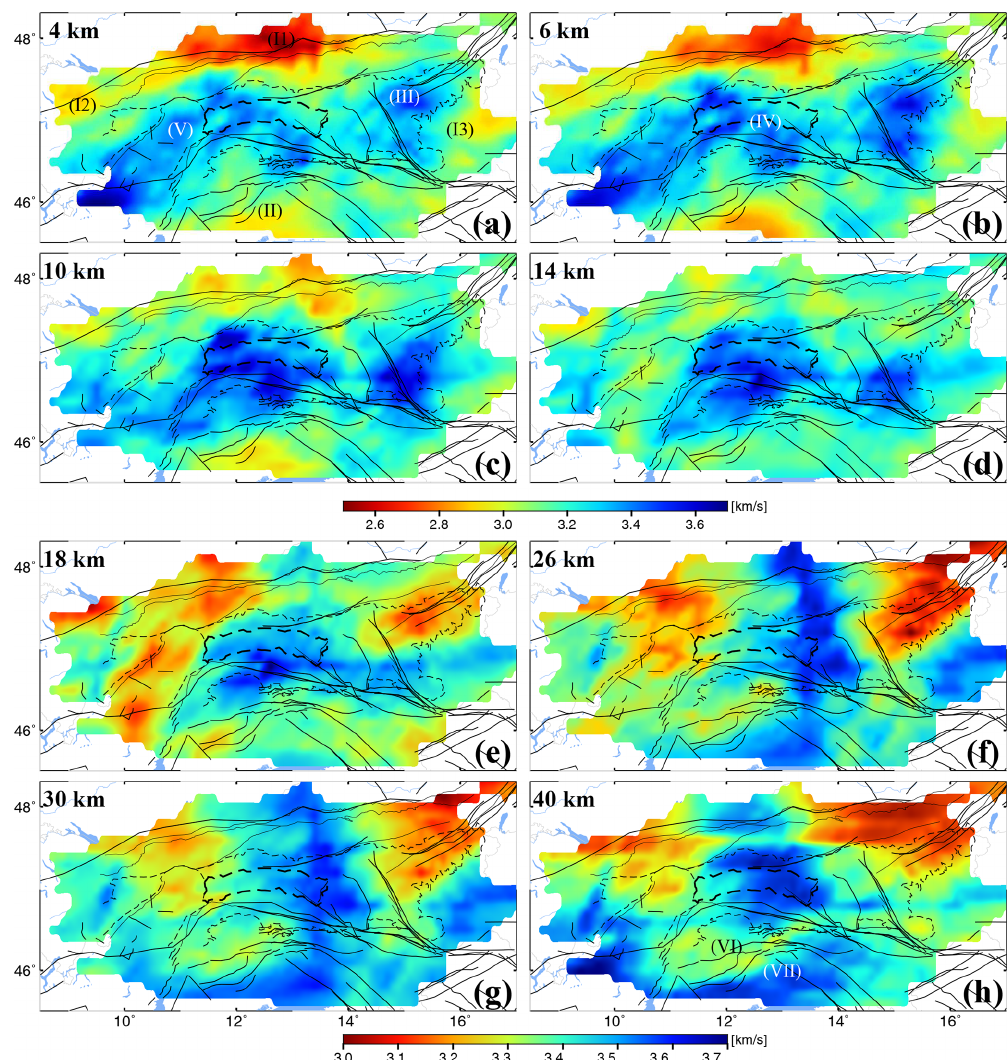
Figure 11. Shear velocity model derived from inversion of the Rayleigh-wave group velocity maps. Black lines represent the main faults in the region (modified from Schmid et al., 2004). Dashed lines show the main geological units of the region (geological map of the Eastern Alps, Egger et al., 1999; Fig. S4) to be compared with the velocity patterns, together with numbers indicating the geographical regions discussed in the “Results and discussion” section. See the text for the velocity anomalies marked by Roman